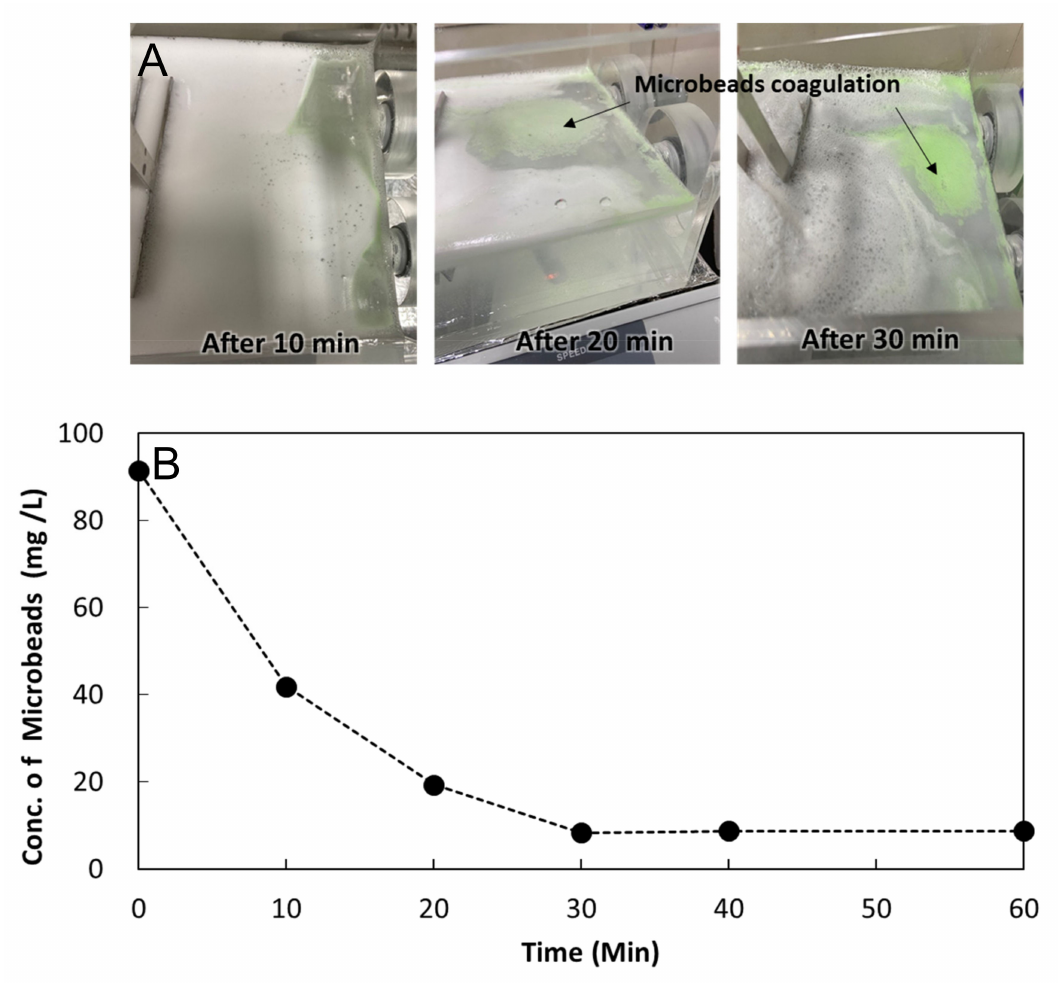
Figure 7. Results of the electro-coagulation experiment: ( A ) progress of microbeads aggregation; ( B ) concentration of the in- separable microbeads by centrifugation with time elapsed. Each data point is the mean value from the duplicate